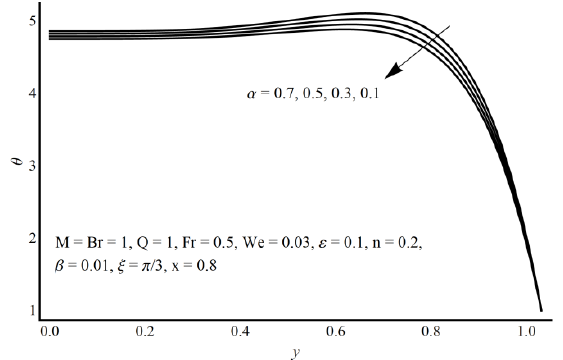
Figure 8. Temperature profile for different values of α.